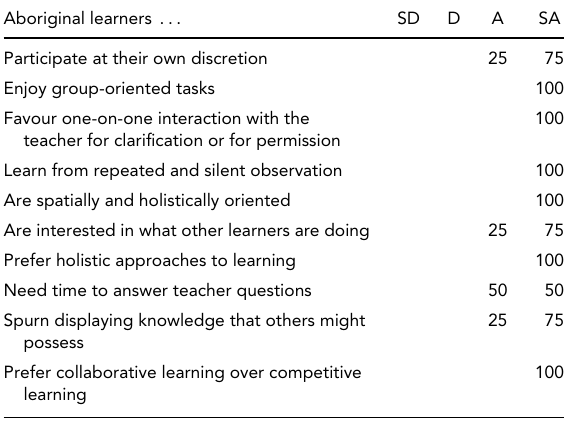
Aboriginal Learning Preferences Survey Results (in Percentages) Aboriginal learners ... SD